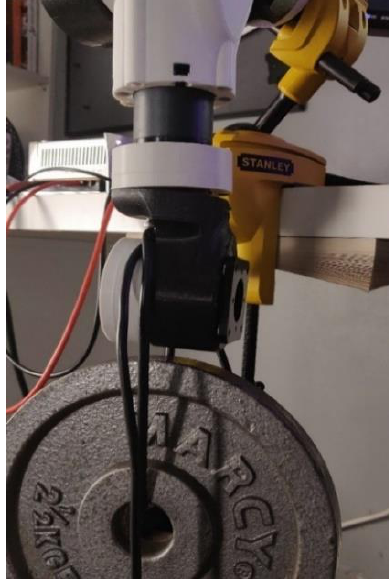
Figure 7. The benchmark for testing the torque capability of the